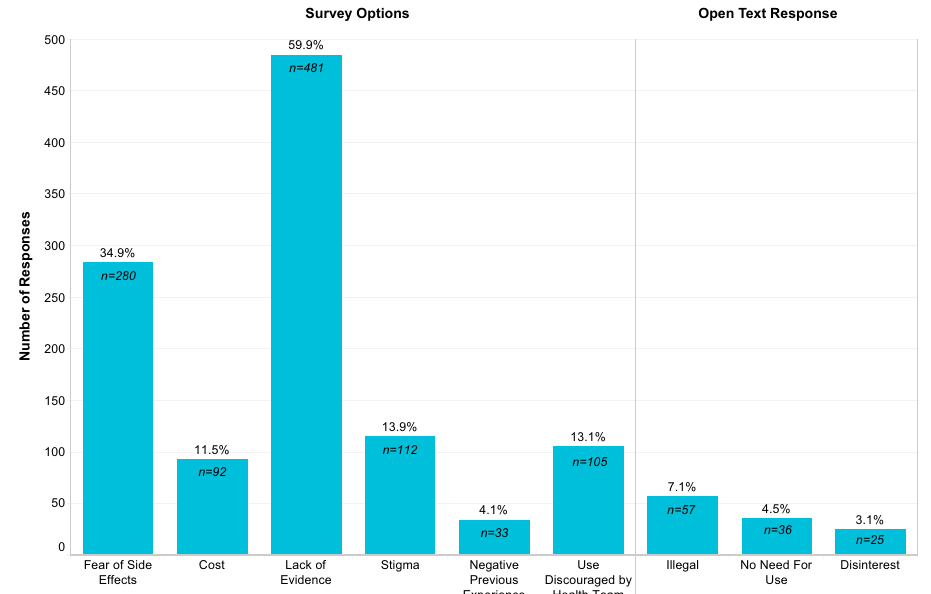
Fig. 2 Primary reasons for not using Cannabis in the past 6 months ( n = 803). Responses were either pre-identi fi ed in the survey as options listed in the category labels or individuals selected “ other ” and their open text response was analyzed thematically.